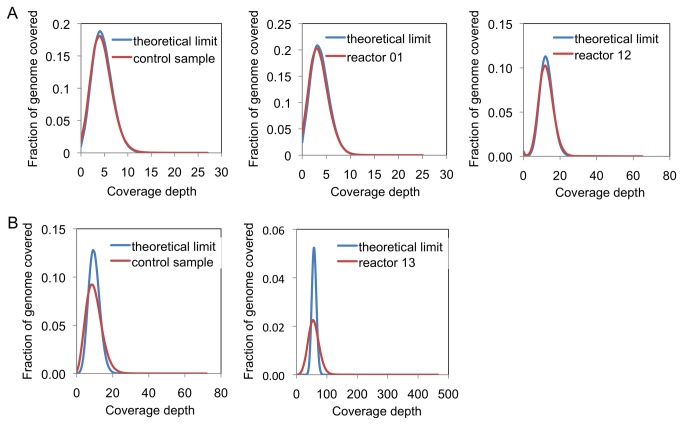
Coverage depths from sequencing runs using E. coli strain DH10B libraries prepared on the AMCC chip.(a) Ion Torrent libraries were run on the Ion Torrent PGM using the 100 bp sequencing protocol. (b) Illumina libraries were run on the MiSeq using the 2x25 bp paired-end sequencing protocol. Libraries labeled "Control" were prepared off-chip using the standard benchtop protocols recommended by each manufacturer. Sequencing runs with uniform coverage are expected to yield a Poisson distribution of coverage depths, indicated by the curves labeled "Theoretical limit".